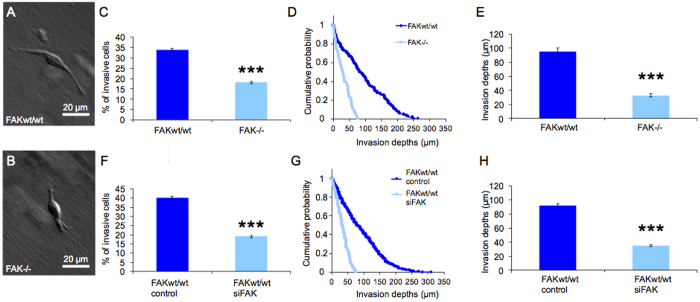
FAK expression correlates with increased invasiveness of fibroblasts into 3D extracellular matrices.(A,B) Representative images of invading cells showing FAKwt/wt fibroblast (A) at 110 μm invasion depth and FAK−/− fibroblast (B) at 43 μm of invasion depth. (C) Three days after seeding on dense 3D matrices, the relative number of invasive FAKwt/wt cells, given as mean ± SD, is increased compared to FAK−/− cells. (D) The invasion profiles and (E) the average invasion depths demonstrate a significantly higher invasiveness of FAKwt/wt compared to FAK−/− cells. Similar results were obtained by siRNA based knock-down of FAK in FAKwt/wt cells using specific siFAK. (F) The percentage (mean ± SD) of invasive FAKwt/wt cells treated with siFAK is markedly decreased compared to controls treated with unspecific control siRNA. (G) Invasion profile and (H) average invasion of FAKwt/wt cells treated with siFAK confirm loss of invasive behavior after FAK knock-down. (n = 4, p*** < 0.001). Reduction of FAK to below 1/3 of control was verified by quantification of mRNA and protein levels (Supplementary Fig. S1 and Table S1).